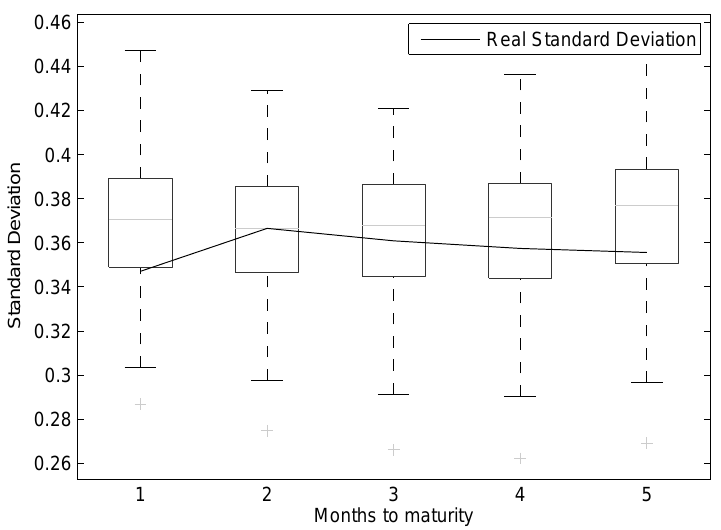
Figure 10. Box plots of the standard deviation of simulated time